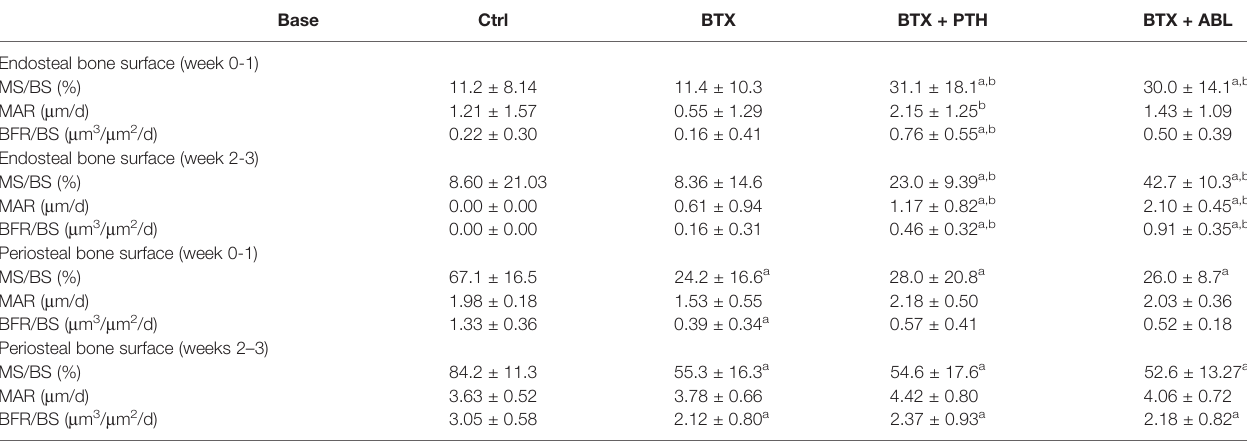
TABLE 5 | Dynamic bone histomorphometry at the cortical femoral mid-diaphysis of rats with the right hindlimb immobilized with BTX and treated with PTH or ABL.